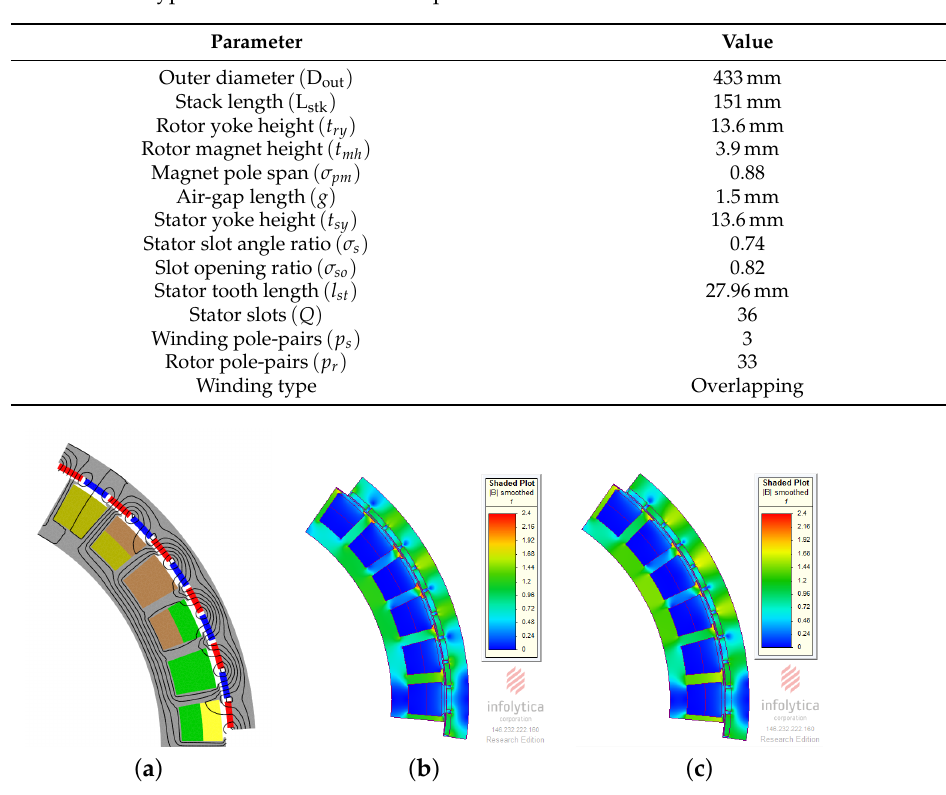
Figure 22. Prototype PMVM (1/6th) FEM simulation results: ( a ) no-load flux lines, ( b ) no-load flux density distribution, and ( c ) full-load flux density distribution.